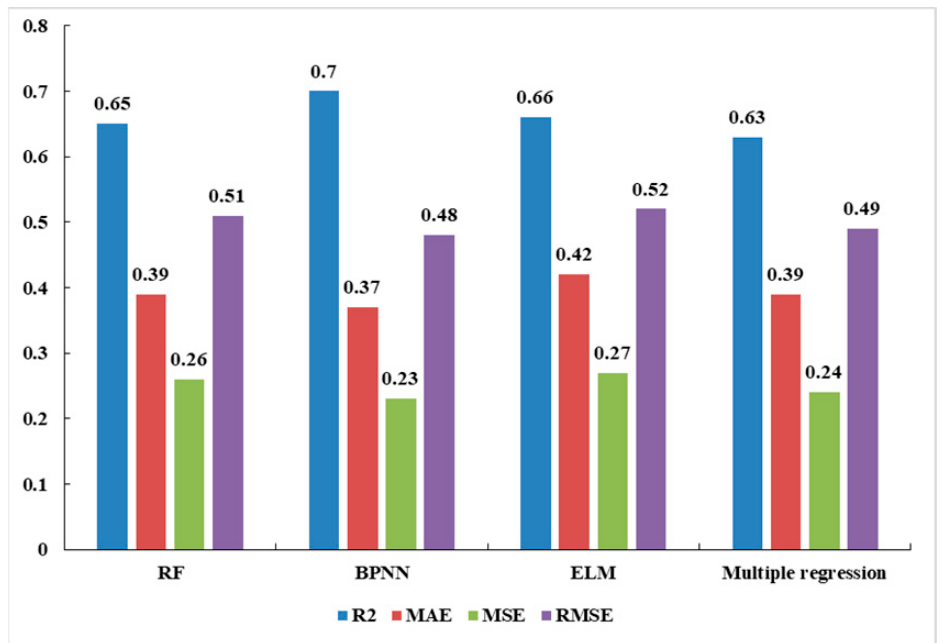
Figure 11. Error analysis of each model using HXC.